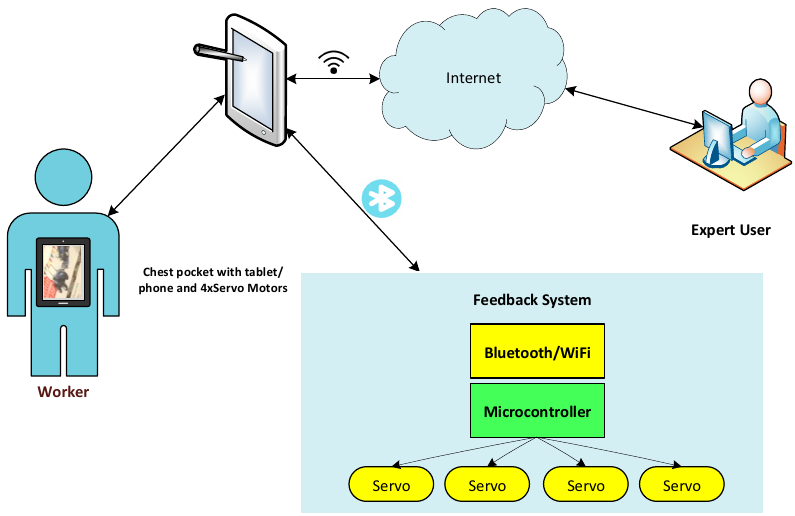
Figure 5. Gutsy-Avatar [53] system diagram. Remote Manipulator (ReMa) [54] focuses on reproducing the local object’s manipula- tion of the remote site using a proxy object. At the tracking site, the object’s manipulations are captured by infrared cameras and are transmitted to the manipulator’s site, where they are displayed on a similar object, called a proxy object. The proxy object is automatically oriented by a robotic arm to reflect the position from the tracking